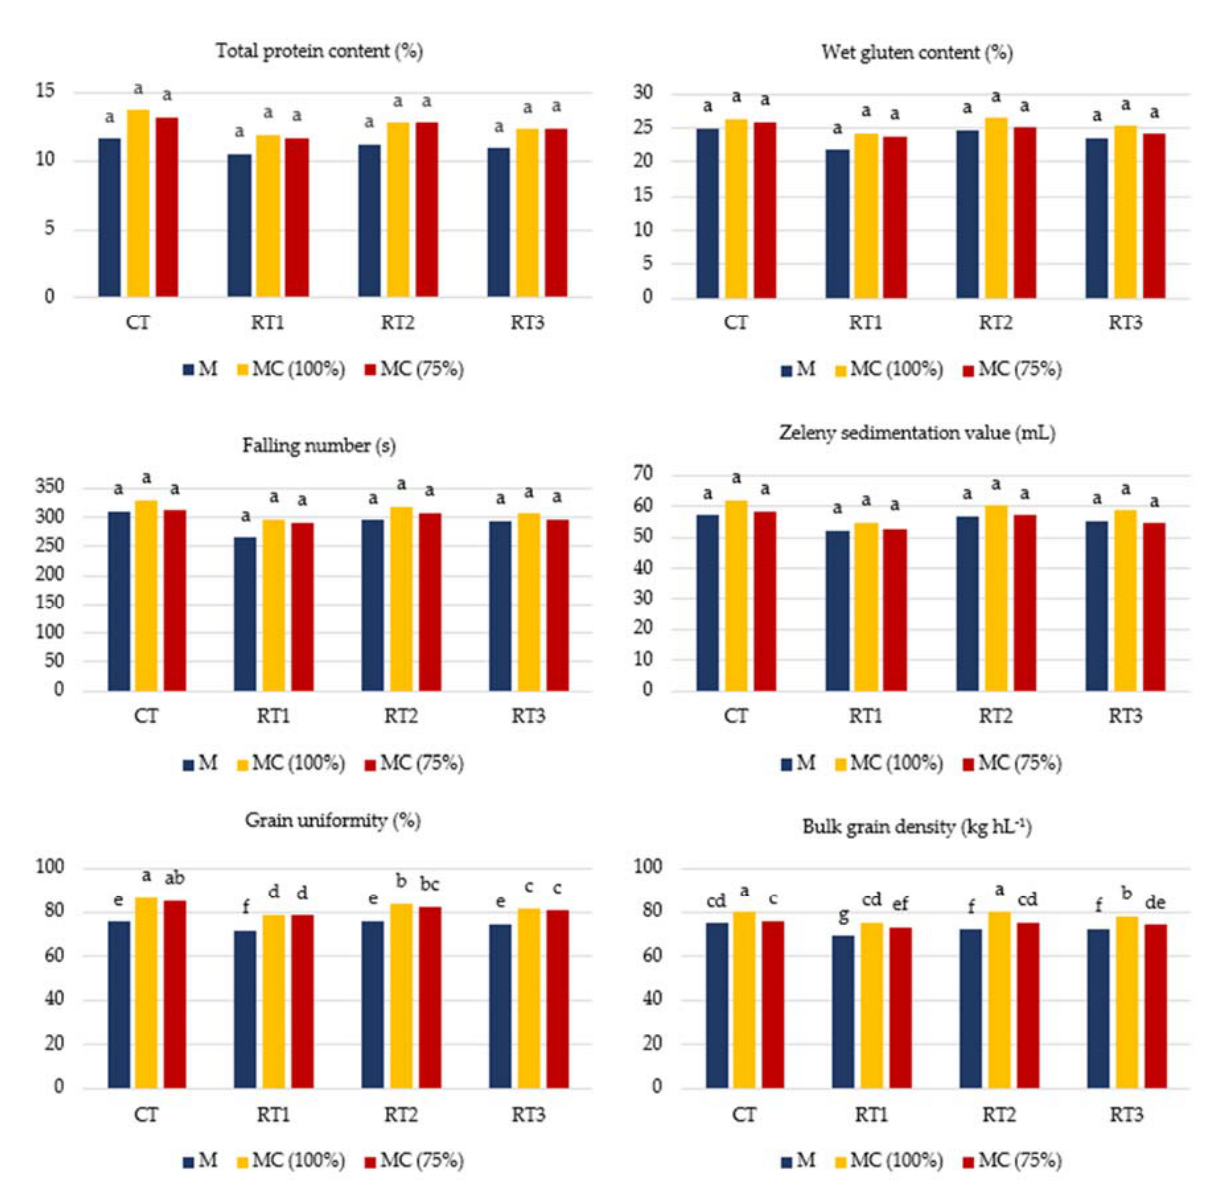
Figure 5. Interaction of the tillage systems and weed control methods in determining quality parameters of spelt wheat grain. CT—conventional tillage; RT1, RT2, RT3—reduced tillage; M—mechanical; MC (100%)—mechanical and chemical (dose of herbicides 100%); MC (75%)—mechanical and chemical (dose of herbicides 75%). Different letters denote significant differences ( p ≤ 0.05). The same letter represents not significantly different values ( p ≤ 0.05).